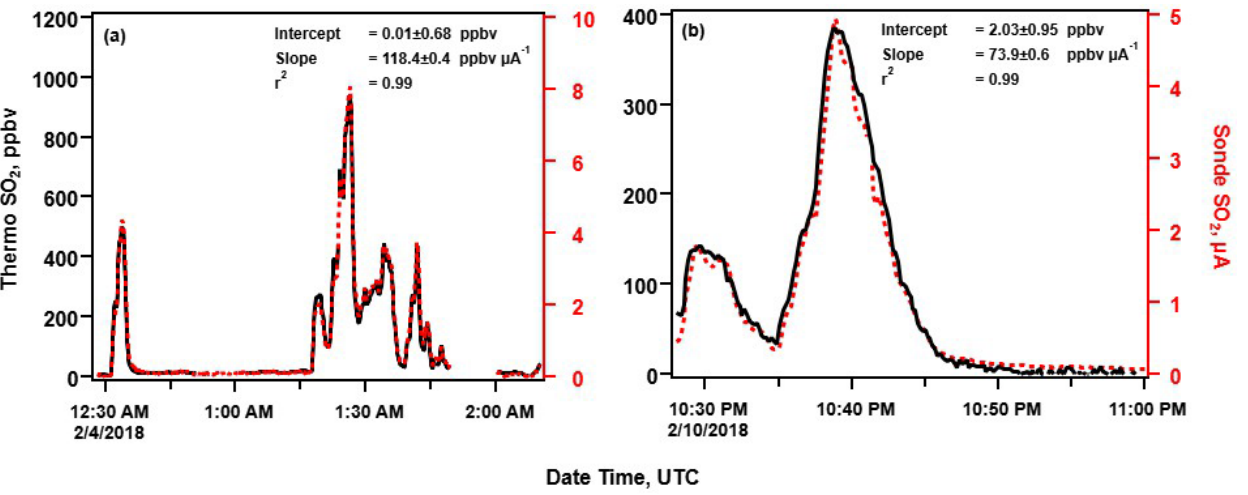
Figure 4. SO 2 sonde v1.0 and Thermo Environmental SO 2 analyzer measurements at K¯ılauea, Hawai’i, during H3C for (a) initial SO 2 plume encounter on 3 February 2018 and (b) a pre-flight measurement on 10 February 2018, approximately 6km downwind of K¯ılauea’s summit crater.